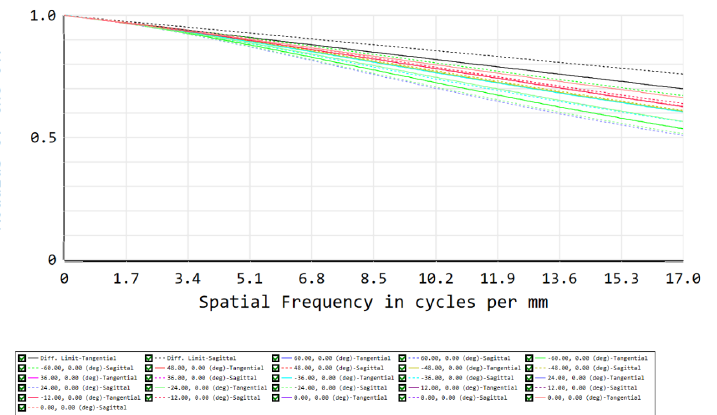
Figure 8. Modulation transfer function (MTF) as the second figure of merit for our telescope’s optical performance. The MTF exceeds 0.5 at 17 cycles/mm, indicating good image quality. The different colors correspond to the different fields shown in Figure